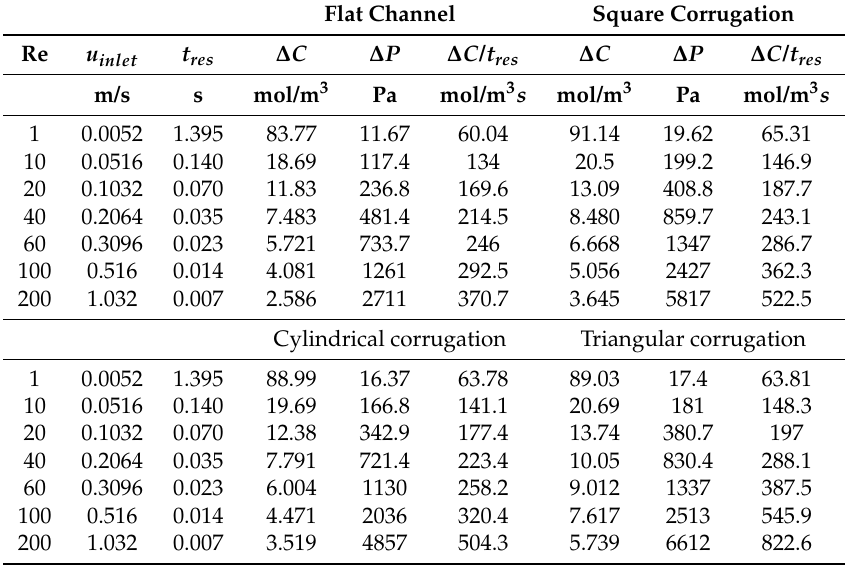
Table A1. ∆ C , ∆ P and mass transfer rate for flat channel and all types of active spacer-filled channels at T = 20 ◦